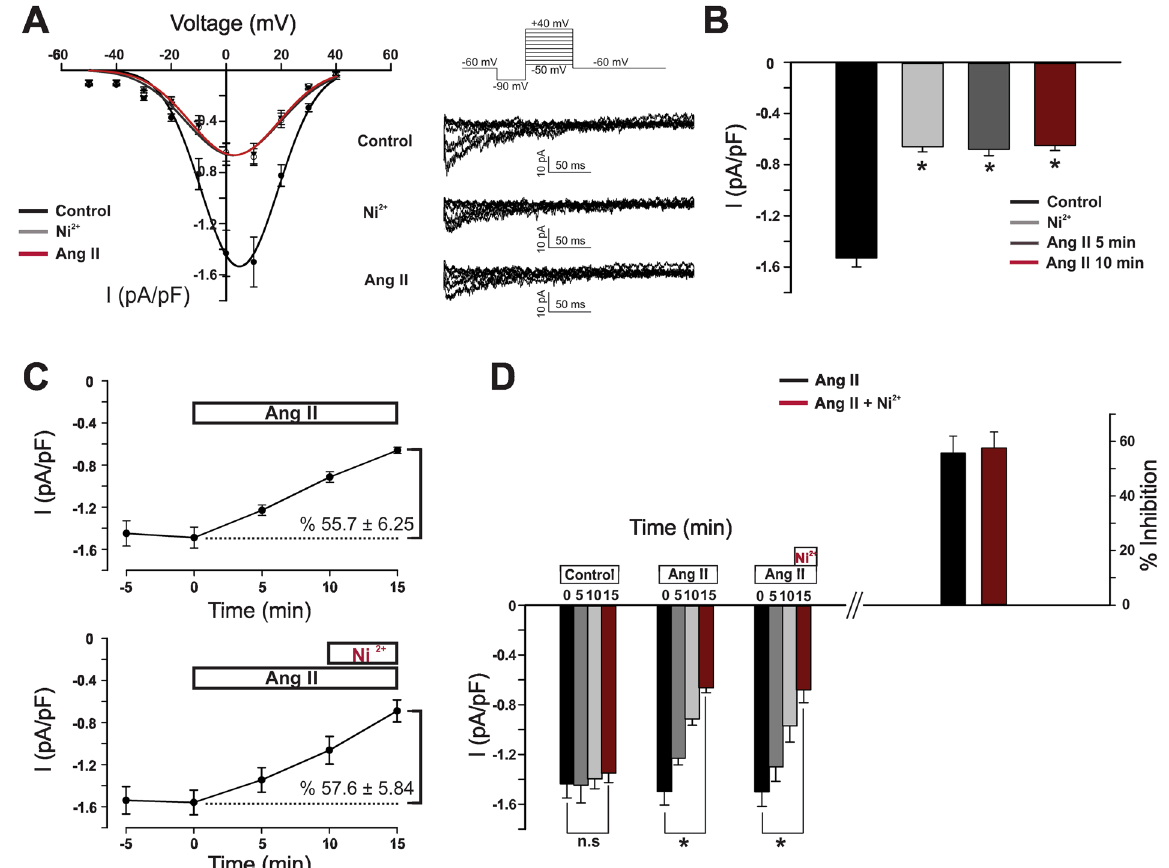
Figure 4. Angiotensin II selectively inhibits Ca V 3.2 channel in cerebral myocytes. ( A ) Representative traces and average I-V plots showing the effect of Ang II (100 nM) on the residual Ni 2 + -insensitive T-type current (n = 8). ( B ) Summary data highlighting the inability of Ang II to inhibit the peak T-type current (pA/pF) in cells treated with Ni 2 + (Ca V 3.2 blocker, 50 µ M) (n = 8). ( C ) T-type current (I max , pA/pF) suppression by Ang II in the absence (top, n = 8) and presence (bottom, n = 6) of Ni 2 + . ( D ) Left bar graph illustrate change in peak T-type current (5 min time intervals) under control conditions (n = 8) or in presence of Ang II ± Ni 2 + (n = 6–8); right bar graph displays % inhibition of the T-type current. * Denotes significant difference compared to control ( * P < 0.05, paired t